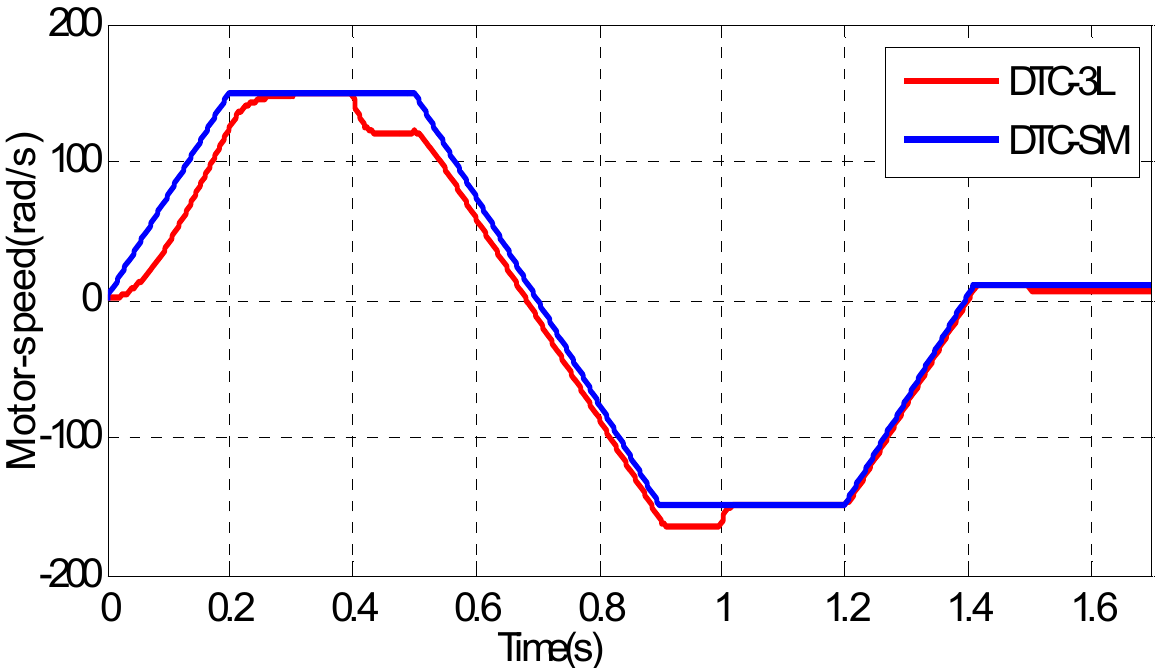
The figure exhibiting the motor speed with the DTC of the three‑level inverter‑fed IM drive and DTC based on sliding mode theory, with a change in load level during operation, is illustrated in Figure 10.